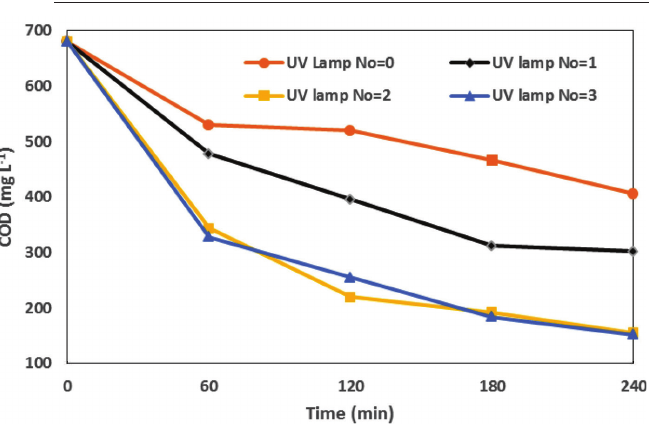
Fig. 4 – Effect of UV intensity on COD removal of high sa- linity petrochemical wastewater using PPc (Voltage: 1.5 V, pH = 4, reaction time: 240 min, and electrode distance: 2 cm)